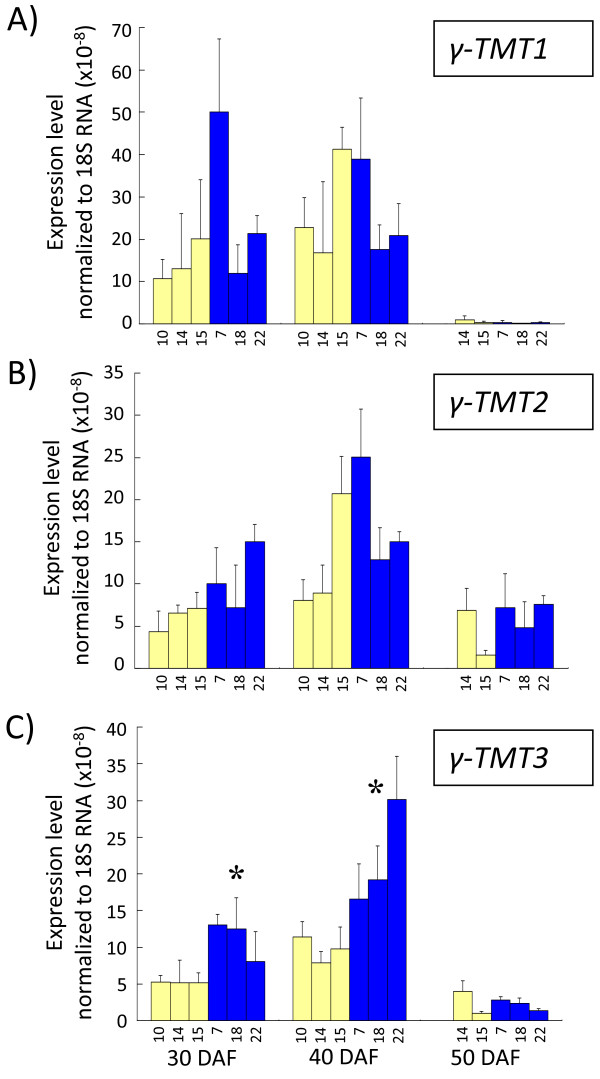
Gene expression analysis of γ-TMT1 (A), γ-TMT2 (B), and γ-TMT3 (C) during seed development. Quantitative RT-PCR was performed on total RNA from 30 DAF, 40 DAF, and 50 DAF developing seeds by using the gene-specific primers listed in Table 4. Yellow bars represent HIF-derived homozygous Ichihime lines (F5-24-10, F5-24-14, and F5-24-15) and blue bars represent HIF-derived homozygous KAS lines (F5-24-7, F5-24-18, and F5-24-22). For 30 DAF, and 40 DAF seeds, analysis was performed with all six lines, whereas for 50 DAF seeds, analysis was conducted with five of the six lines (F5-24-14, F5-24-15, F5-24-7, F5-24-18, and F5-24-22). Transcript levels were normalized with the values obtained for the internal control 18S-ribosomal RNA. Values represent the mean of three replicates ± SD. Asterisks show significant differences between the Ichihime genotype group and the KAS genotype group (confidence interval 95%).